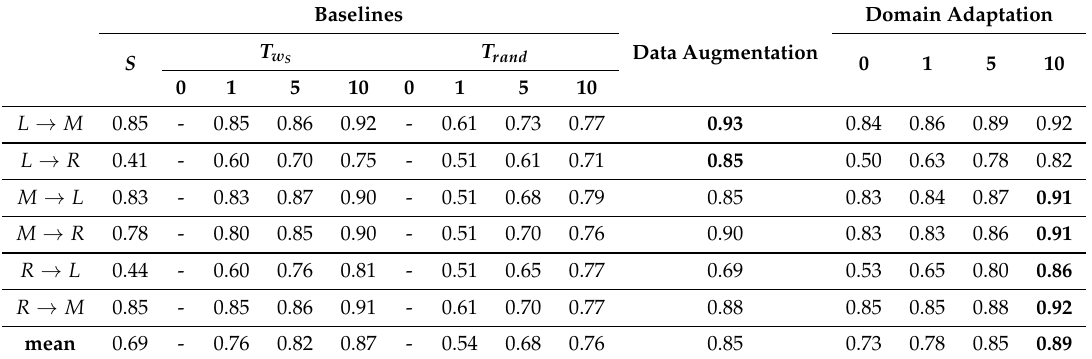
Table 1. Experimental results. Figures represent average accuracy percentages over ten runs. In each setup best accuracy achieved is indicated with bold. For each viewpoint adaptation scenario, for example, “Left to Middle” (indicated L → M ) the four numbers (0, 1, 5 and 10) indicate the percentage of target data instances which are labelled. S is the source model, built by a simple cross-view experiment. T rand and T w denote models whose initial weights have been taken randomly and from S , respectively. Note that S with no labeled data in the target domain (i.e., 0) these models cannot be trained and hence these columns are omitted.